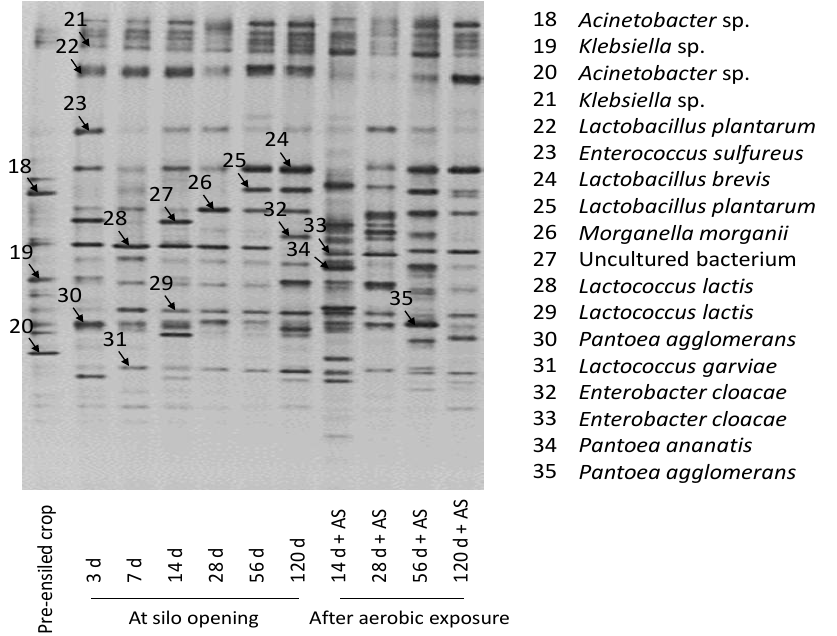
Figure 2. Bacterial communities in the ensiling process of direct-cut guinea grass silage. Silos were opened after 3, 7, 14, 28, 56, and 120 d and a 7-d aerobic stability test was conducted for the silages from the latter 4